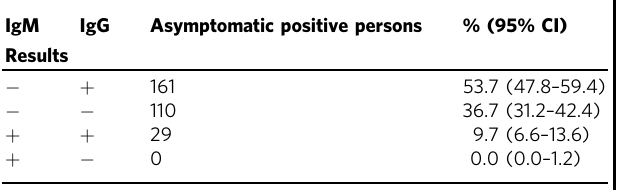
Table 2 Results of the detection of antibody in 300 asymptomatic positive